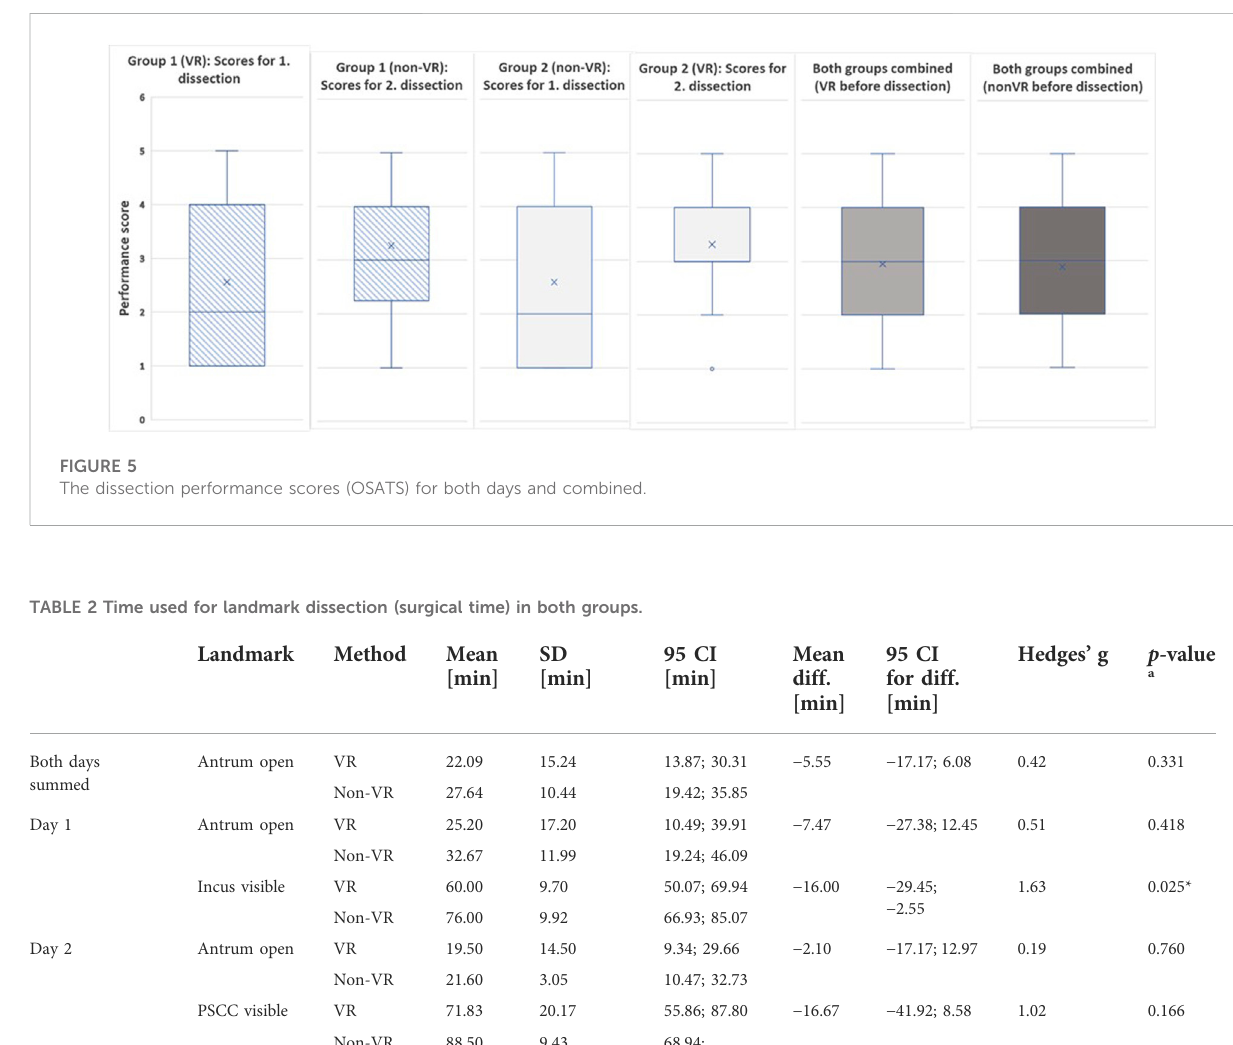
Landmark Method Mean